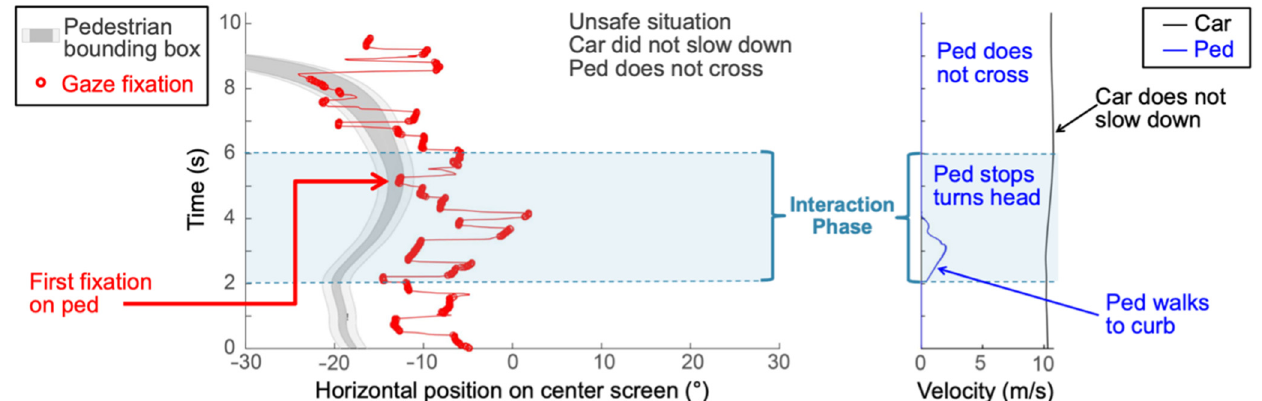
Figure A2. Data for a participant with a left HVFD for an event in which a human-controlled pedestrian (HCped) crosses from the left (blind) side of the participant in a drive when the ADAS was engaged. The pink horizontal line indicates the time of the ADAS trigger. Soon after the hazard warning, the participant scanned to the left, which led to an early fixation on the HCped and a safe street crossing. The participant decelerated gently, and the HCped crossed the street.